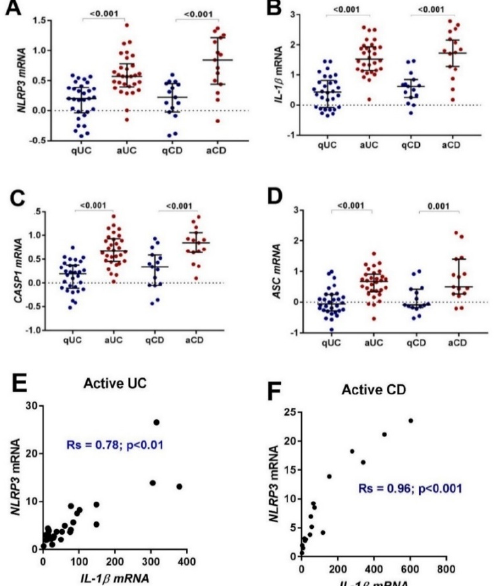
Figure 1. Gene expression and correlation of NLRP3 inflammasome related genes in paired biopsies from quiescent UC (qUC), active UC (aUC), quiescent CD (qCD) and active. CD (aCD). The mRNA expression of ( A ) NLRP3 , ( B ) IL-1 β , ( C ) CASP1 , and ( D ) ASC was compared to a healthy control group and normalized to the housekeeping gene, EEF2. Individual patient results are shown as dots. Horizontal lines indicate the median relative expression (R.E) and error bars represent the interquartile ranges. Group differences were tested using Mann-Whitney test of log 10 transformed data. E) The correlation of NLRP3 and IL-1 β mRNA in active UC. F) The correlation of NLRP3 and IL-1 β mRNA in active UC. The significance threshold was p <